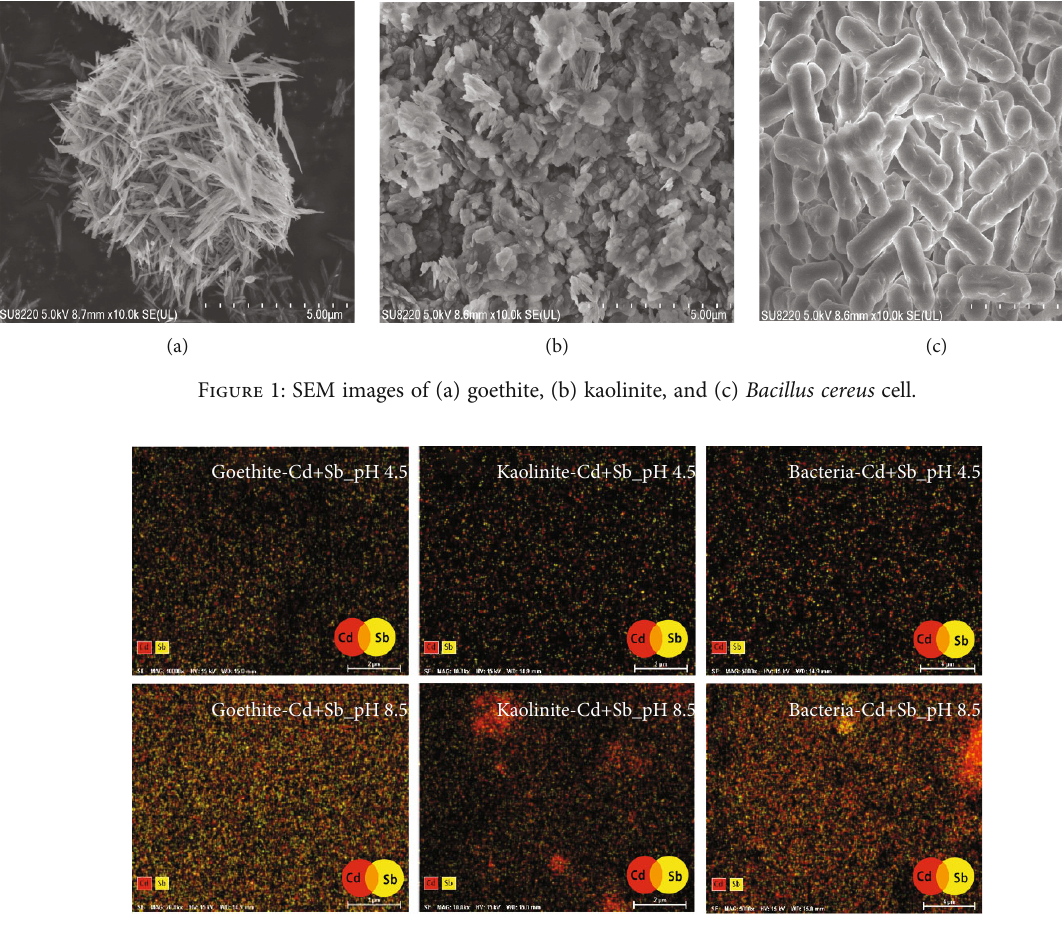
Figure 2: SEM-ED mapping of goethite, kaolinite, and Bacillus cereus cell after the sorption of Cd(II) and Sb(V) at pH 4.5 and 8.5.